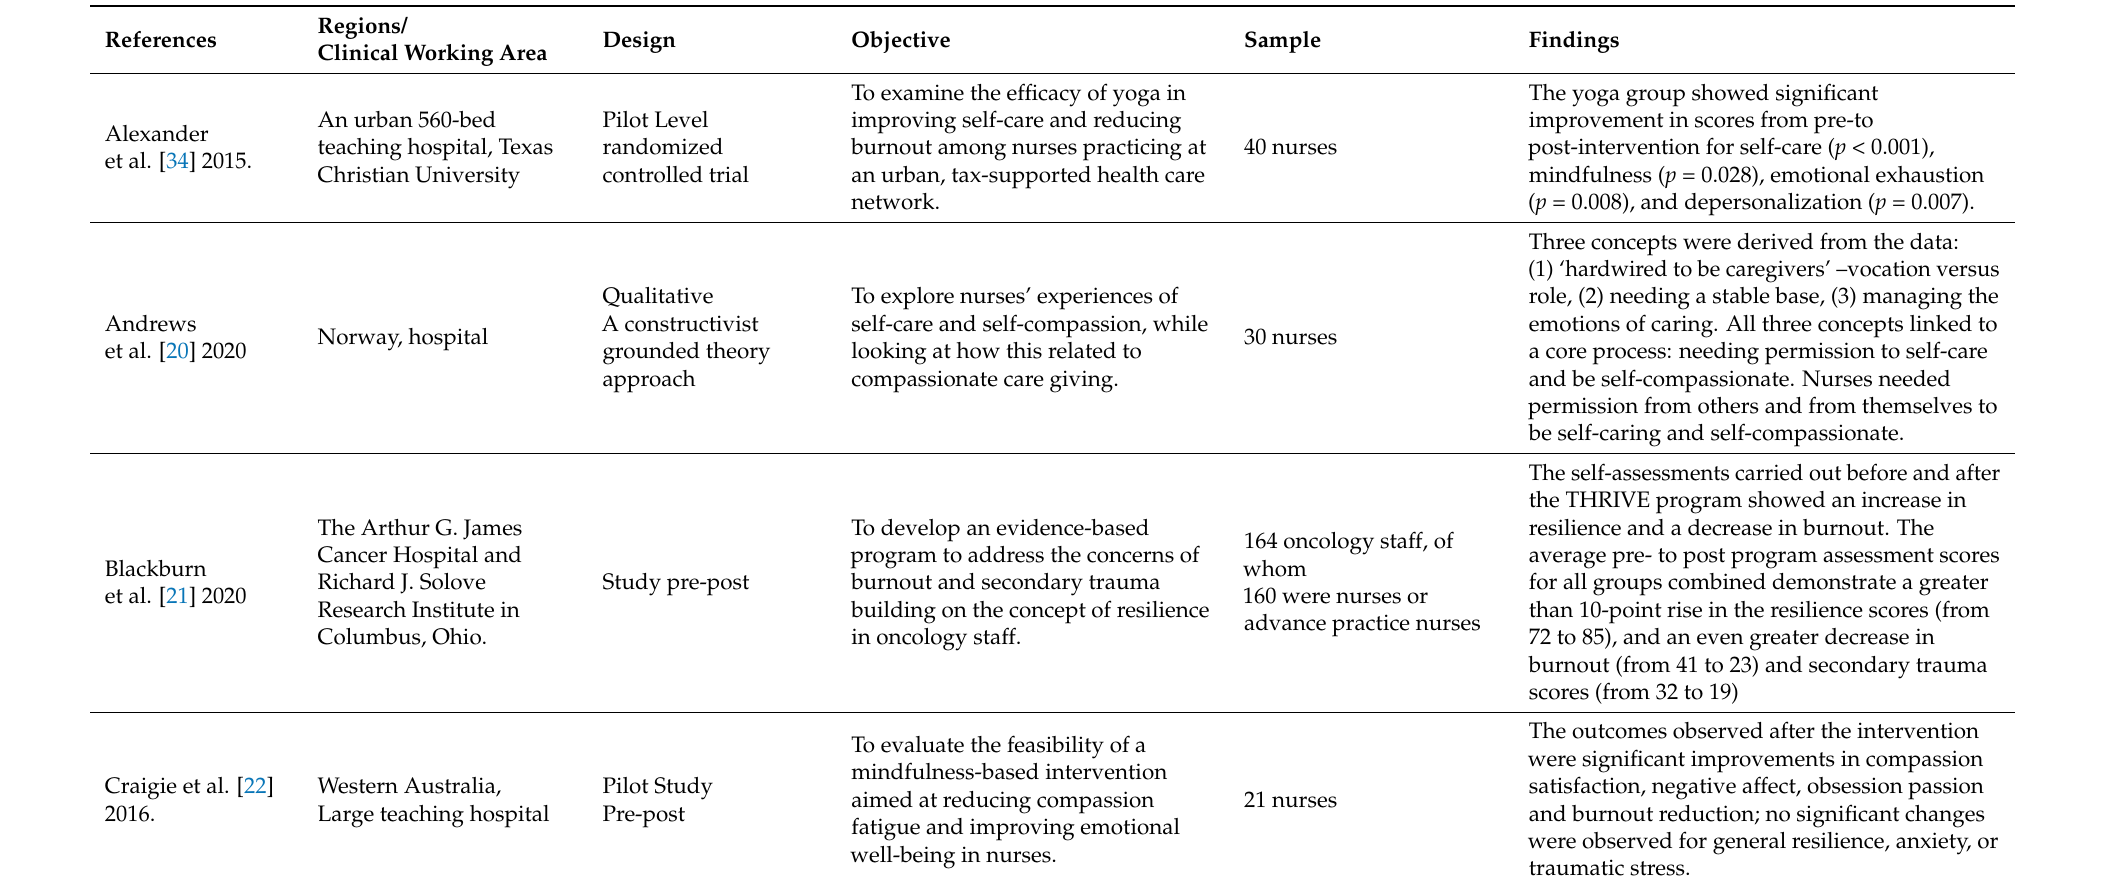
Table 2. Characteristics and main results of the studies included in the systematic